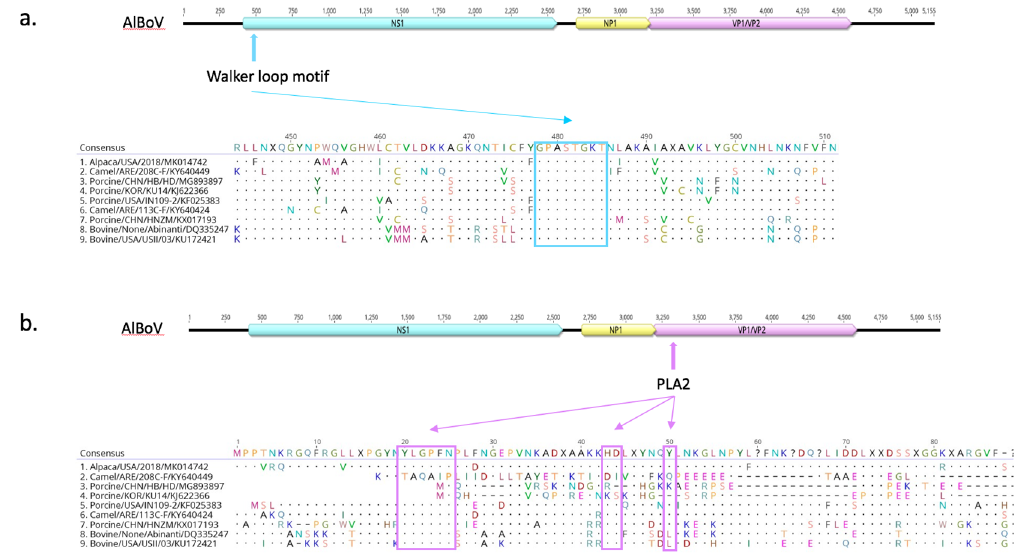
Figure 4. Detection of ATP and GTP-binding Walker-loop motif in NS1 protein ( a ) and Phospholipase A2 (PLA2) motif in N-terminal of VP1 protein ( b ). Dots indicate residues matching the consensus sequence and dashes represent gaps in the